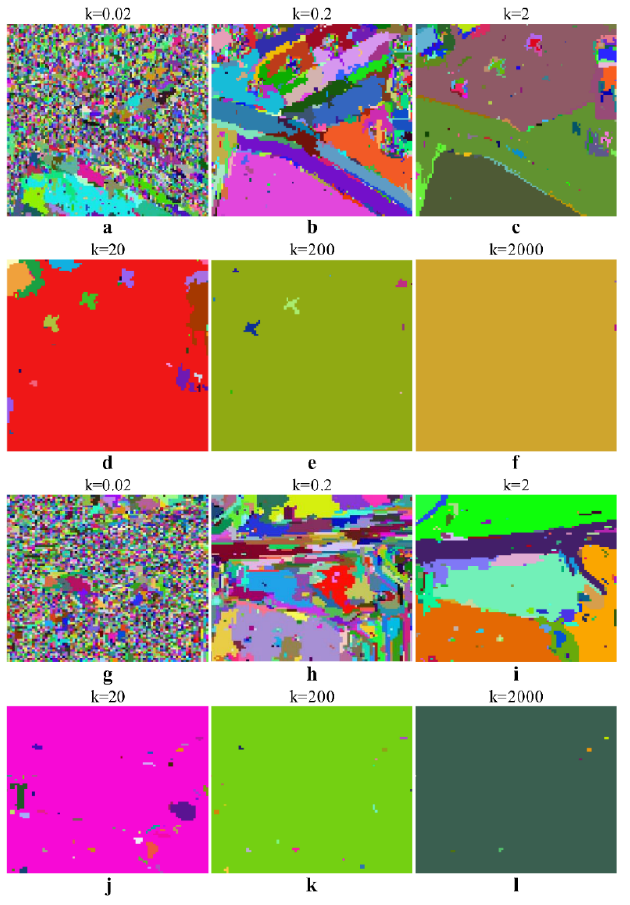
Figure 9. Different oversegmentation results for the two real-world HSIs with K = 0.02, 0.2, 2, 20, 200, and 2000; ( a – f ) correspond to the AVIRIS San Diego airport data and ( g – l ) correspond to the HYDICE urban data.